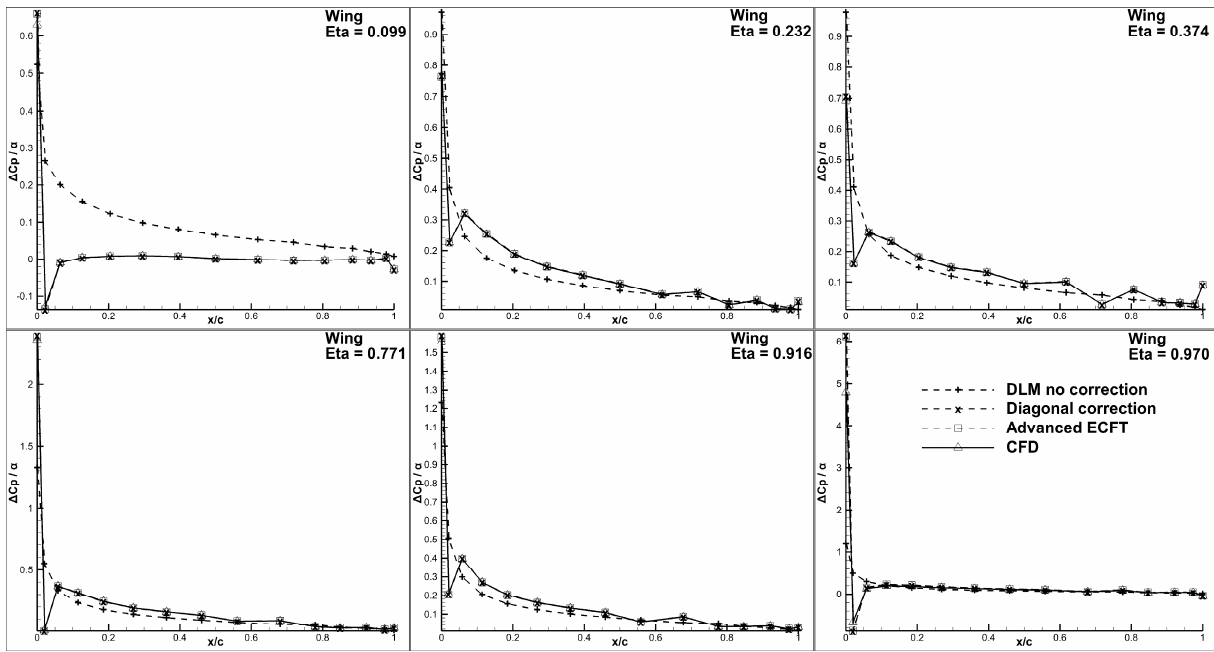
Figure 6. Rigid Δ Cp for a unit α at Wing Component.